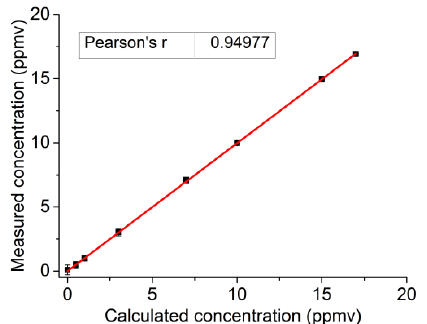
Figure 2. Measurements of different acetone concentrations at 200 mbar plotted as a function of calculated acetone concentrations from the mixing ratio with nitrogen (10 averaged scans in 30 s) including the linear fit.